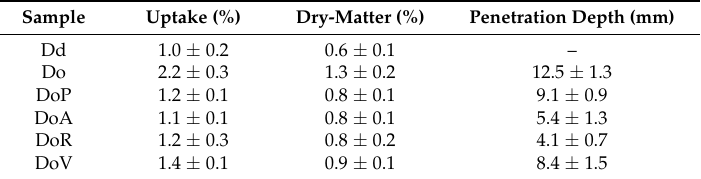
Table 5. Uptake and depth of penetration of the applied